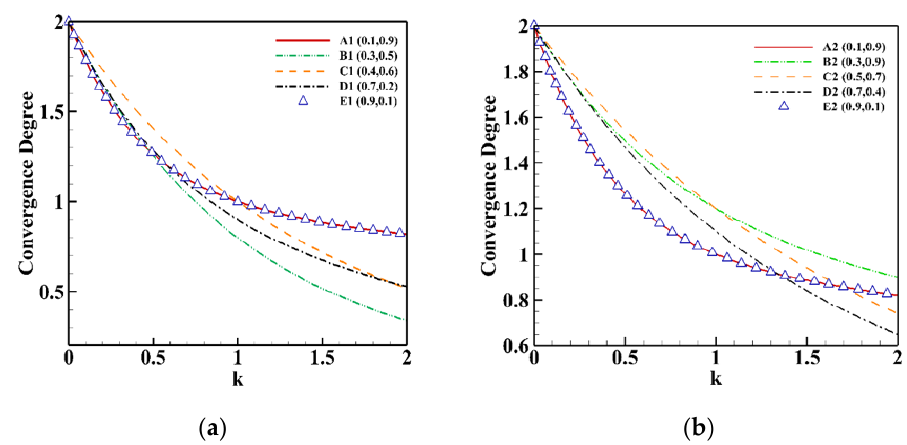
Figure 2. ( a ) Convergence degree of solutions A1 (0.1,0.9), B1 (0.3,0.5), C1 (0.4,0.6) , D1 (0.7,0.2) and E1 (0.9,0.1) for convex problem and ( b ) convergence degree of solutions A2 (0.1,0.9), B2 (0.3,0.9), C2 (0.5,0.7), D2 (0.7,0.4) and E2 (0.9,0.1) for concave problem whenever 𝑘 ∈ [0,2] .